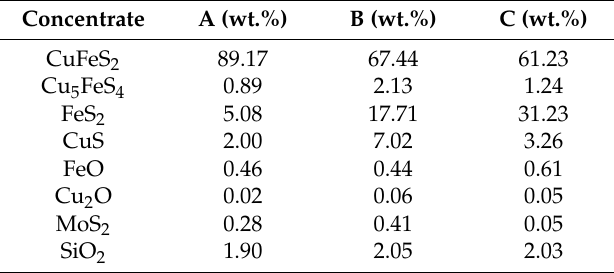
Table 1. Concentrates mineralogical composition.